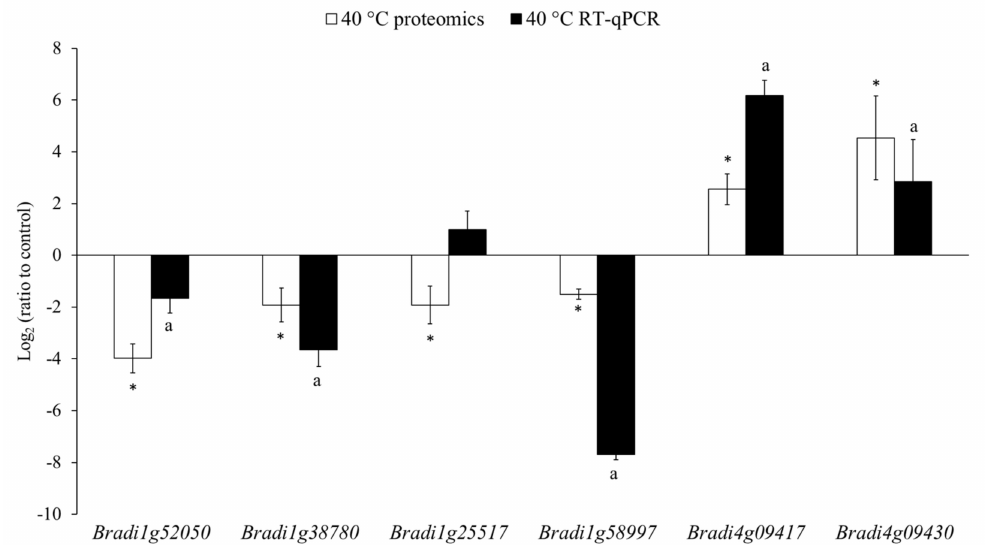
Figure 2. Comparison between the relative expression levels of the six genes that were measured using RT-qPCR and the relative level of the accumulation of the encoded proteins. Bradi1g52050 encodes a polygalacturonase (GH28), Bradi1g38780 a GDSL-lipase/acylhydrolase, Bradi1g25517 an endo- β -1,3-glucosidase (GH17), Bradi1g58997 a CIII Prx (BdiPrx35), Bradi4g09417 a class II chitinase (GH18) and Bradi4g09430 another GH18. The polyubiquitin gene ( Bradi1g32860 ) was used as the reference gene for the RT-qPCR measurements and the control treatment (at 21 ◦ C) as the reference group for all the calculations. The error bars of RT-qPCR results represent the standard deviations that were calculated from three biological replicates and two technical replicates for each biological replicate. The letter “a” indicates significant differences from the control using the Student’s t-test ( p < 0.05; mean ± SD, n = 3). The error bars indicated for the quantitative proteomic results represent the standard deviations that were calculated from four biological replicates. Asterisks indicate significant differences from the control using the Student’s t -test with the permutation-based FDR set to 1% (q-value <